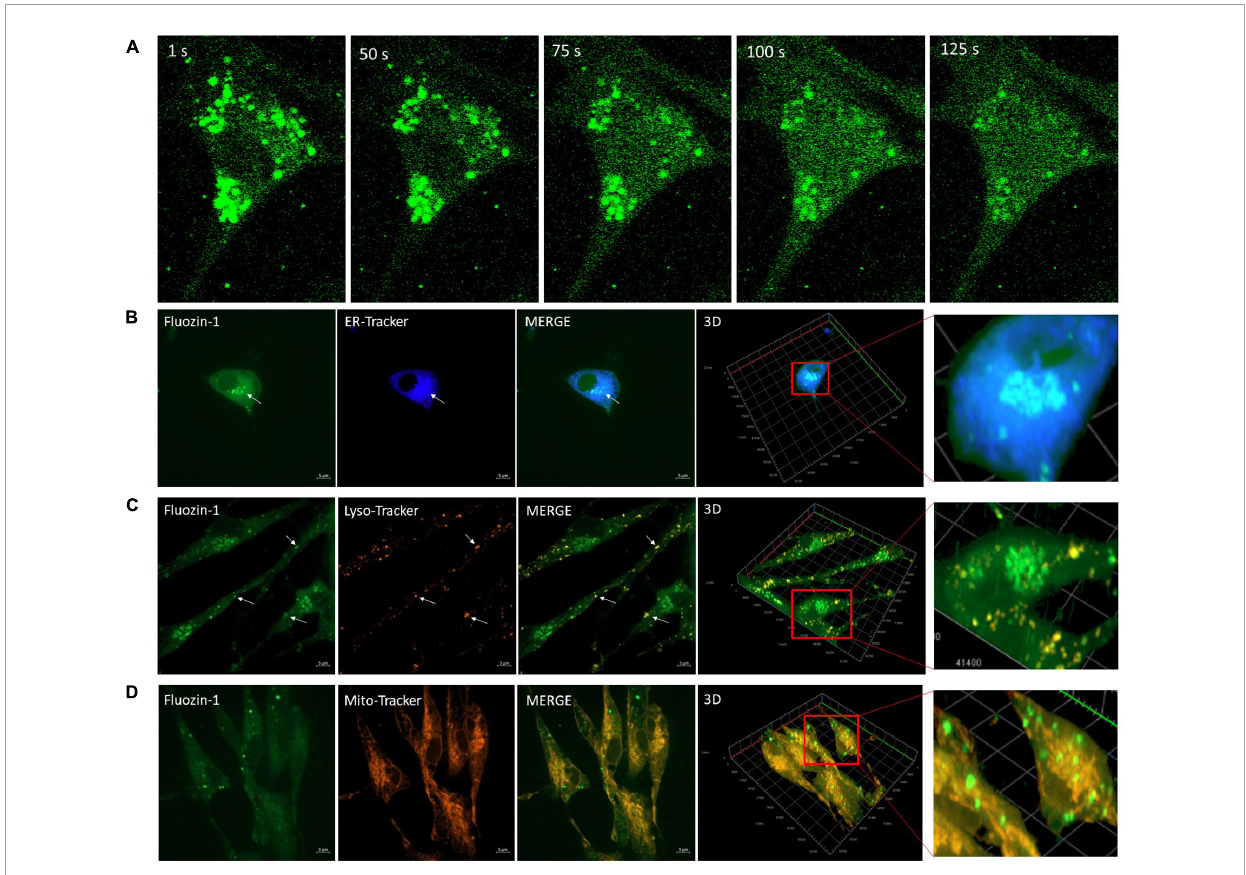
FIGURE5 Vesicular bodies release zinc (Zn 2 + ) in response to electric field stimulation (EFS). (A) Sequential images (100 × magnification) of Fluozin-1 AM labeled cortical cells at the indicated time intervals corresponding to before, during and after exposure to EFS with intensity of 7.69 V/cm. EFS was applied at second 20 of the experiment for a duration of 20 s. (B) Microscopic images of live cortical cells co-loaded with Fluozin-1 AM and ER-Tracker Blue-White DPX to identify co-localization of Zn 2 + enriched vesicles (green) with the ER (blue). An example for co-localization is indicated by the white arrow. Scale bar = 5 µ m. (C) Microscopic image of live cortical cells co-loaded with Fluozin-1 AM, and LysoTracker Red DND-99 to identify co-localization of Zn 2 + enriched vesicles (green) with lysosomes (red). Examples for co-localizations are indicated by white arrows. Scale bar = 5 µ m. (D) Microscopic image of live cortical cells co-loaded with Fluozin-1AM, and MitoTracker Red to identify co-localization of Zn 2 + enriched vesicles (green) with mitochondria (red). Scale bar = 5 µ